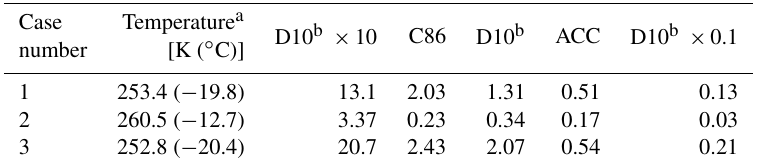
Table 1. Predicted number concentrations of ice crystals, N ice [L − 1 ], using each parameterisation considered in this study at the observed cloud-top temperatures in each case.